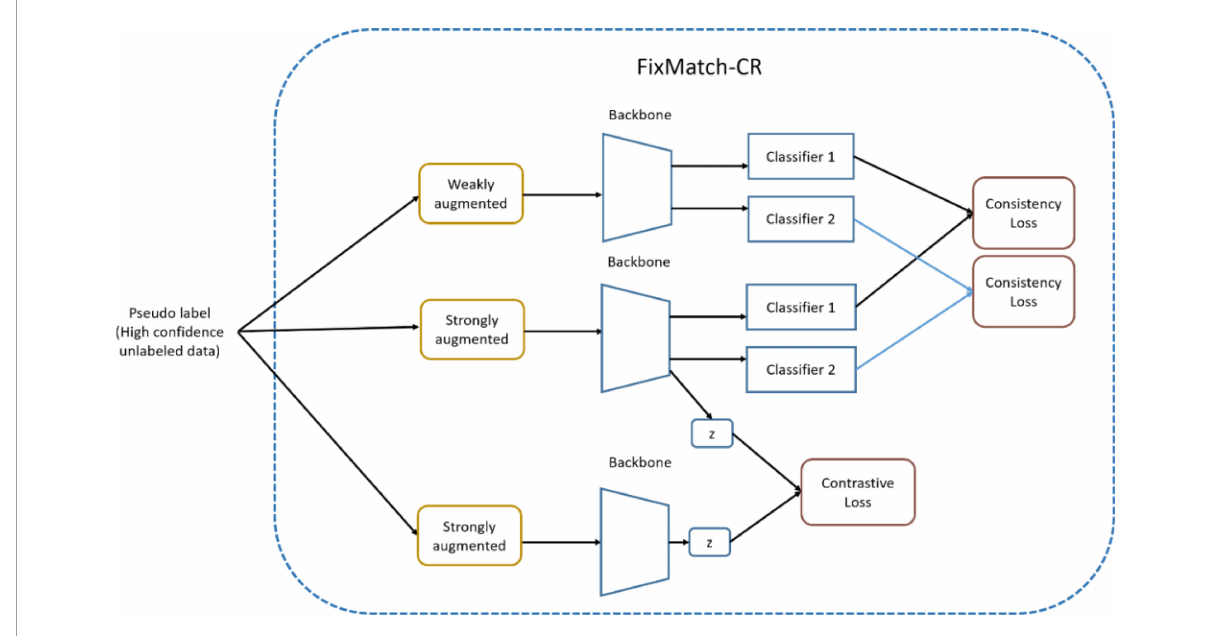
FIGURE6 FixMatch with contrastive regularization in two-head network.